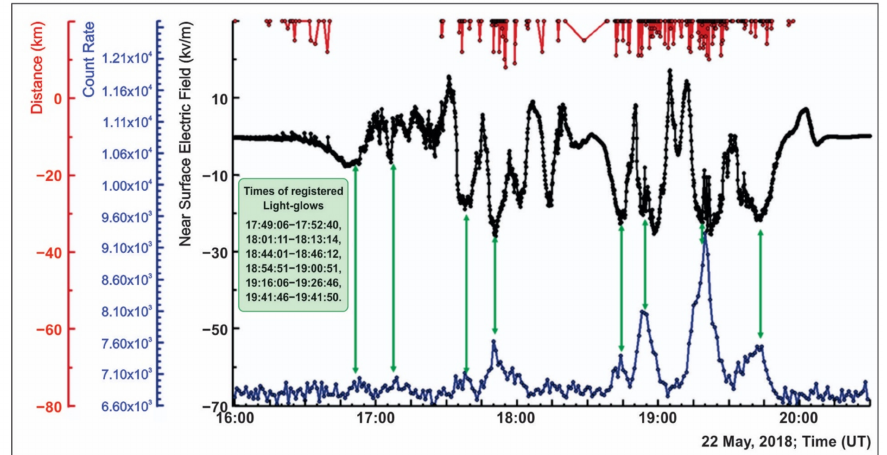
Figure 14. Disturbances of NSEF—black curve, 1 min count rate of the STAND3 particle detector with energy threshold ≈ 4 MeV—blue curve, distances to the lightning flashes—red lines. In inset— times of observed light glows. With green two-sided arrows, we connect TGEs with corresponding disturbances of